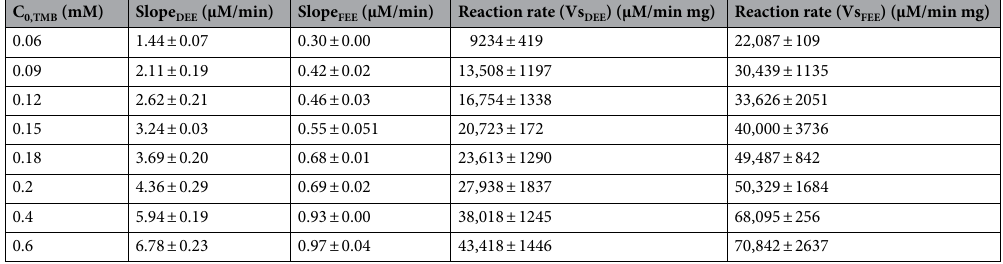
Table 4. The slopes and the reaction rates at different initial concentrations of the substrate.